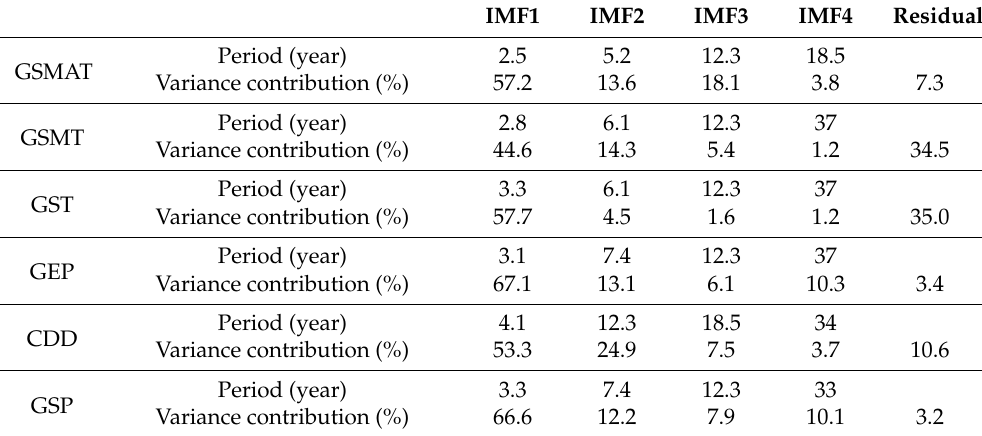
Table 2. The average periods and their variance contributions of climatic factors: GSP, GEP, CDD, GST, GSMAT, and GSMT changes at different timescales in Heilongjiang Province, China during